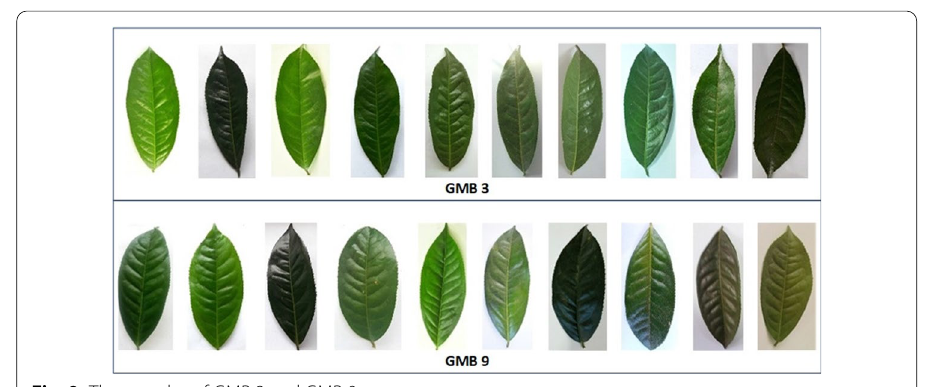
Fig. 9 The samples of GMB 3 and GMB 9